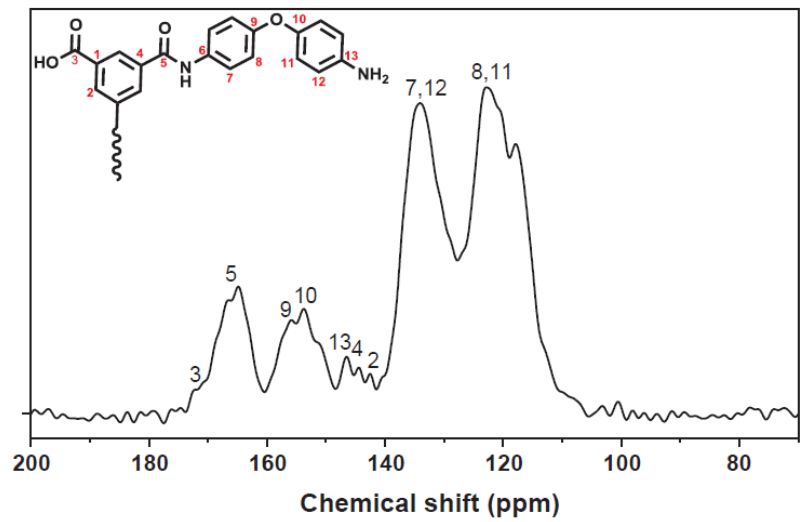
Figure 27. Use of NMR for study the molecular structure of polyetherimide thin film composite membrane [19].